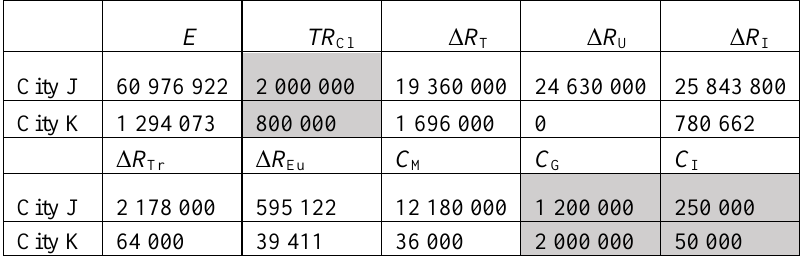
Table 7. Calculation of the Economic Effect (developed by the